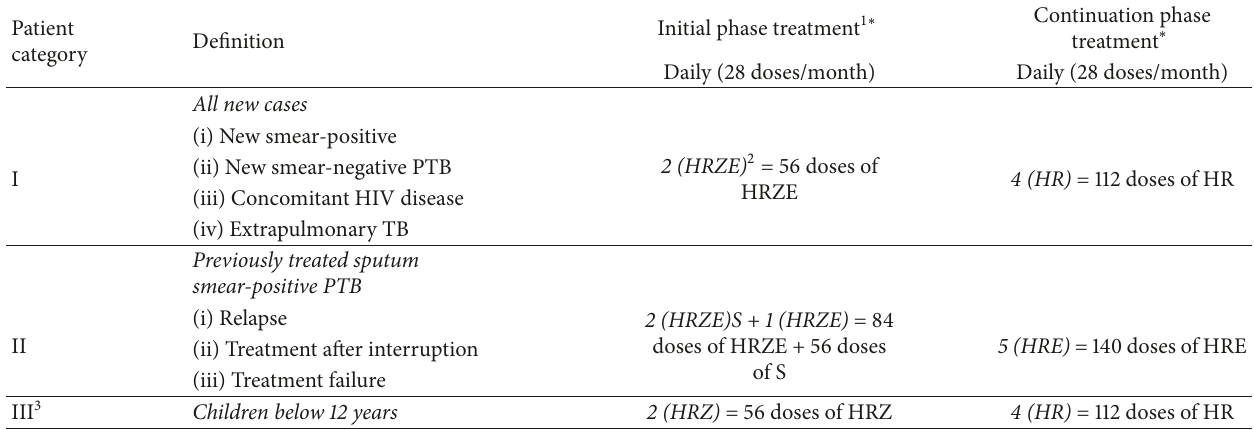
Table 1 is adopted from the National Tuberculosis Programme (NTP) Training Manual, 2012 . 1 Direct observation of treatment intake is required and always in regimens including rifampicin . 2 Streptomycin may be used instead of ethambutol. In meningitis, ethambutol should be replaced by streptomycin . 3 In children with meningitis, add streptomycin in the initial phase . Category I: new clients; category II: previously treated clients; category III: children < 12 years. TB drugs and codes : H: isoniazid; R: rifampicin; Z: pyrazinamide; S: streptomycin; E: ethambutol . Codes for Fixed Drug Combinations (FDC) : (HR): isoniazid +